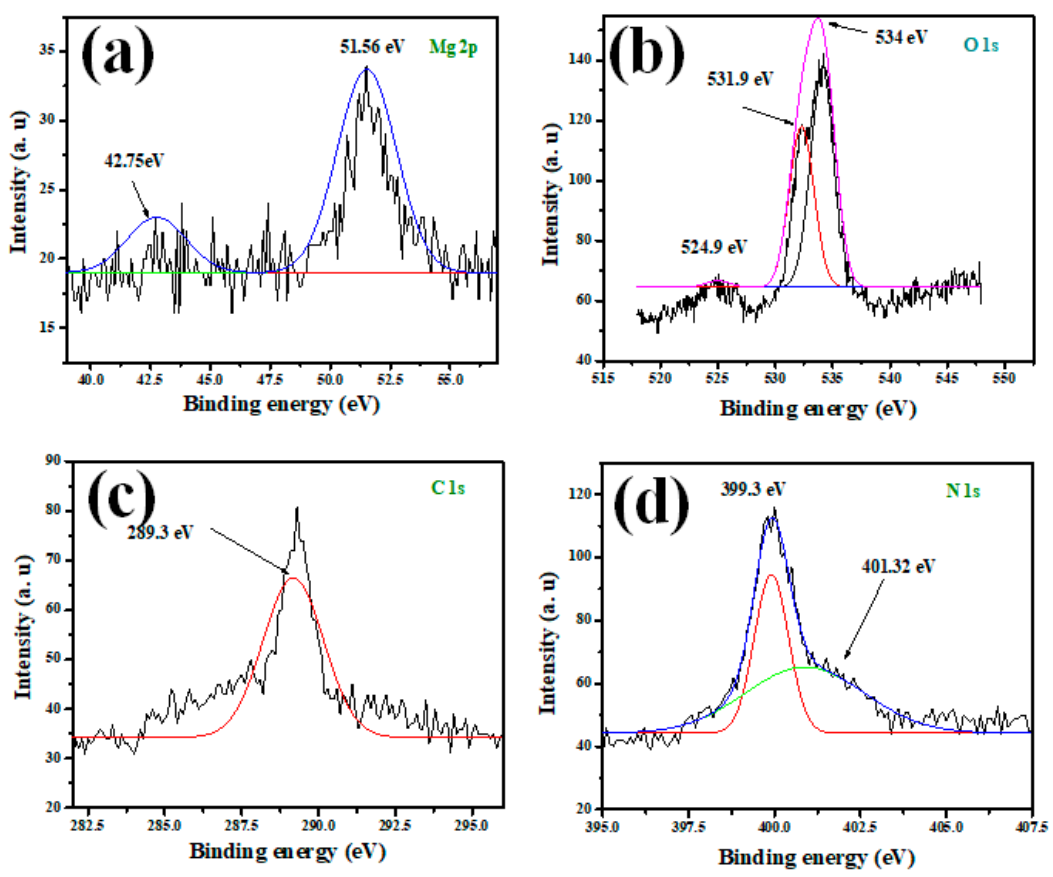
Figure 4. XPS spectra of ( a ) Mg-2p, ( b ) O-1s, ( c ) C-1s, and ( d ) N-1s for MGCN sorbent.